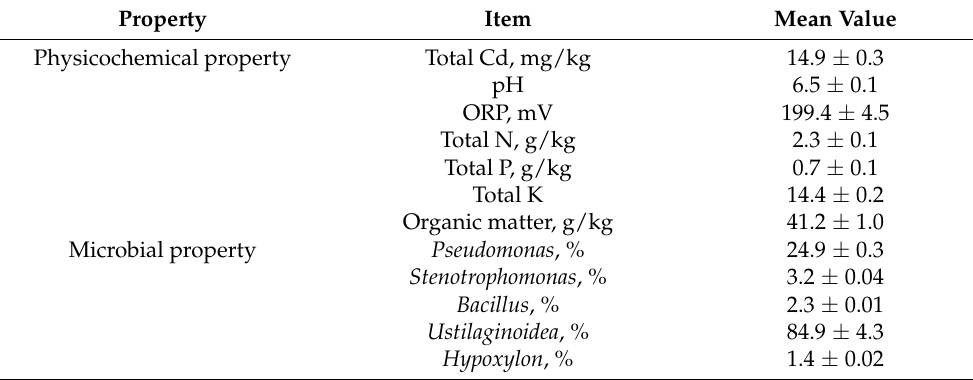
Table 1. Physicochemical properties and dominant genera (mean ± SD, n = 3) of Cd-contaminated soils used in this